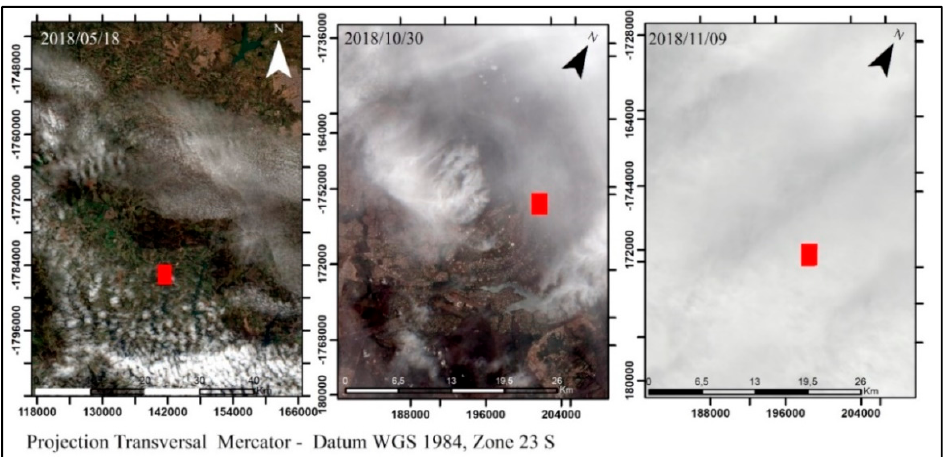
Figure 14. True color red / green / blue (RGB) composite band of Sentinel 2 images totally or partially covered by clouds in dates of airborne surveys.